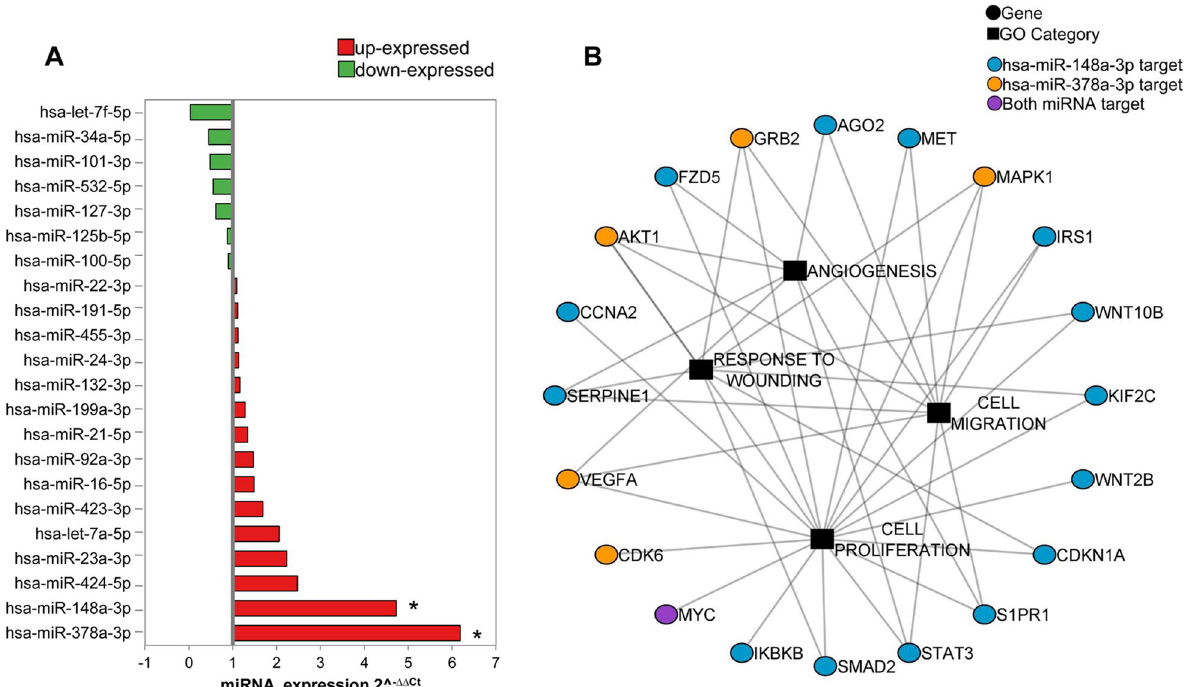
Fig. 4 Analysis of the secretome miRNA cargo. Comparative analysis of miRNA expression in acute hypoxia in relation to normoxia. A The comparative analysis of miRNA expression is represented by the 2‑ΔΔCt (up‑expressed miRNA in red and down‑regulated miRNAs in green). B Interaction network between the target genes of the significantly differentially expressed miRNA and the GO categories to which they are related. Genes are represented by a circle and GO categories by a square. The target genes of hsa‑miR‑148A‑3p are in blue dots and those of hsa‑miR‑378A‑3p are in yellow dots. The only common target gene is indicated in